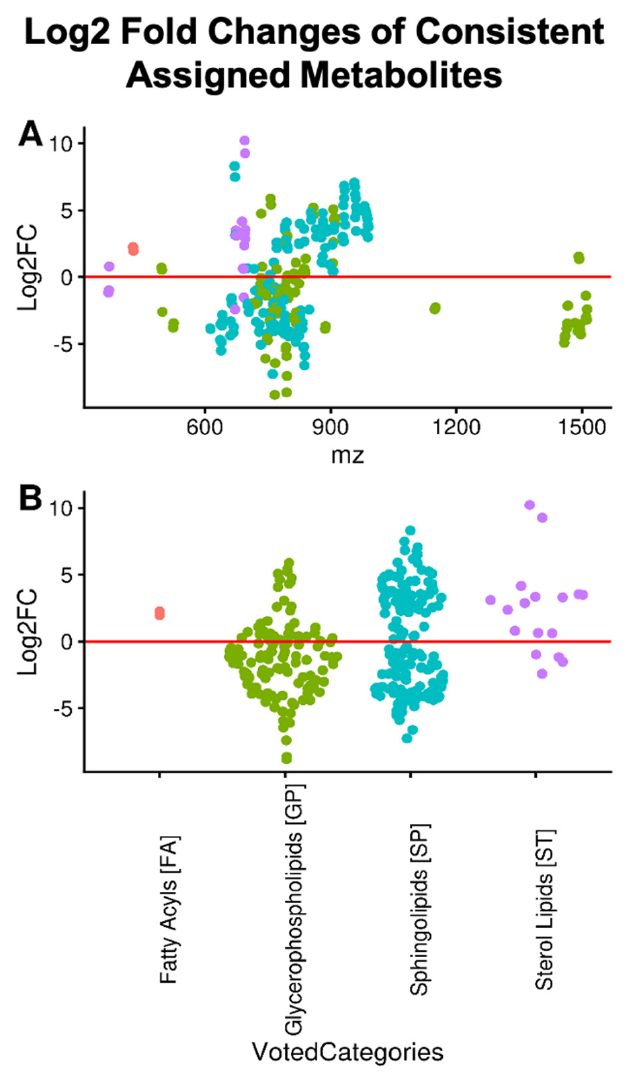
Figure 3. Log2 fold change by category and m/z. The Log2 fold-change (Log2FC) of corresponded peaks assigned to one lipid category are shown in panel ( A ) with respect to m/z and by class in panel ( B ). The extremely high fold-changes observed for some members of the sphingolipid and sterol lipid categories are due, in part, to imputed values. Most of the differentially abundant lipids occur in the 600 to 1000 m/z range; however, this region also has the highest density of assignments. Although no lipid category is exclusively more abundant, sterols are predominantly more abundant while substantial numbers of both sphingolipids and glycerophospholipids are more and less abundant.